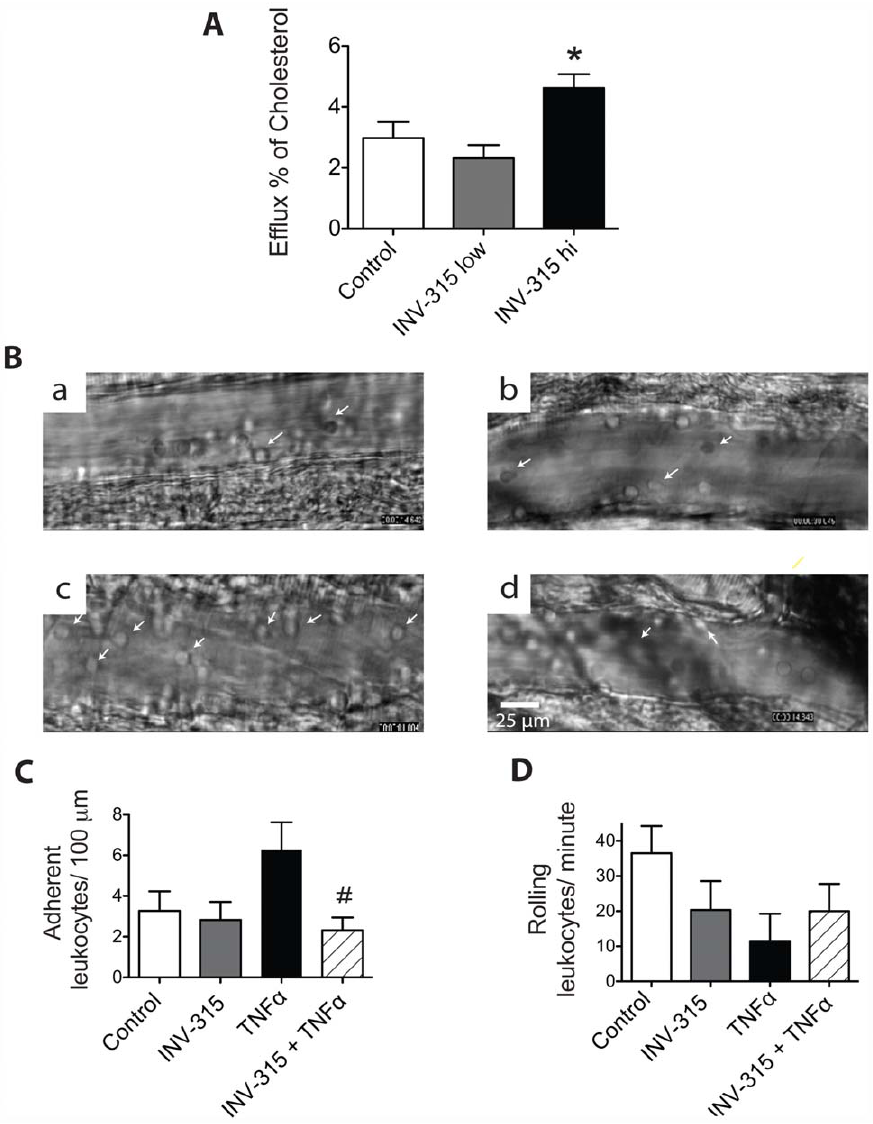
Figure 5. Effects of MPO inhibition on HDL transporting cholesterol and leukocyte adhesion/rolling flux. A. Effects of MPO inhibition on HDL transporting cholesterol from J774 macrophage cells into medium. * P , 0.05, compared with control group. Data are mean 6 S.E.M. of 5–8 experiments from different mice. B. Representative images of adherent leukocytes in the cremasteric microcirculation (cells with arrow heads indicate adherent monocytes, cells without arrow heads indicate rolling leukocytes) via intra-vital microscopy in C57BL/6 mice with different treatment. a, blank control group; b, INV-315treated control; c, TNF a -treated group; d, TNF a -treated groups with INV-315 pretreatment. C and D, Leukocyte adhesion and leukocyte rolling flux in cremasteric microcirculation via intra-vital microscopy in C57BL/6 mice with different treatment. # P , 0.05 compared with TNF a treated group. Data are mean 6 SD of 5 different mice, 5–10 experiments from each animal.